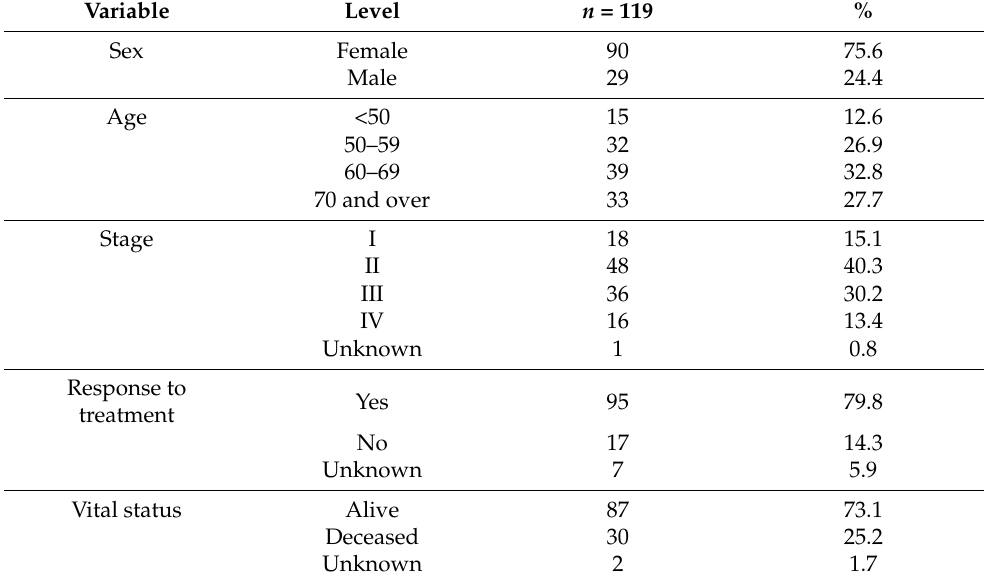
Table 1. Anal cancer cohort: clinical characteristics and demographics with valid NGS